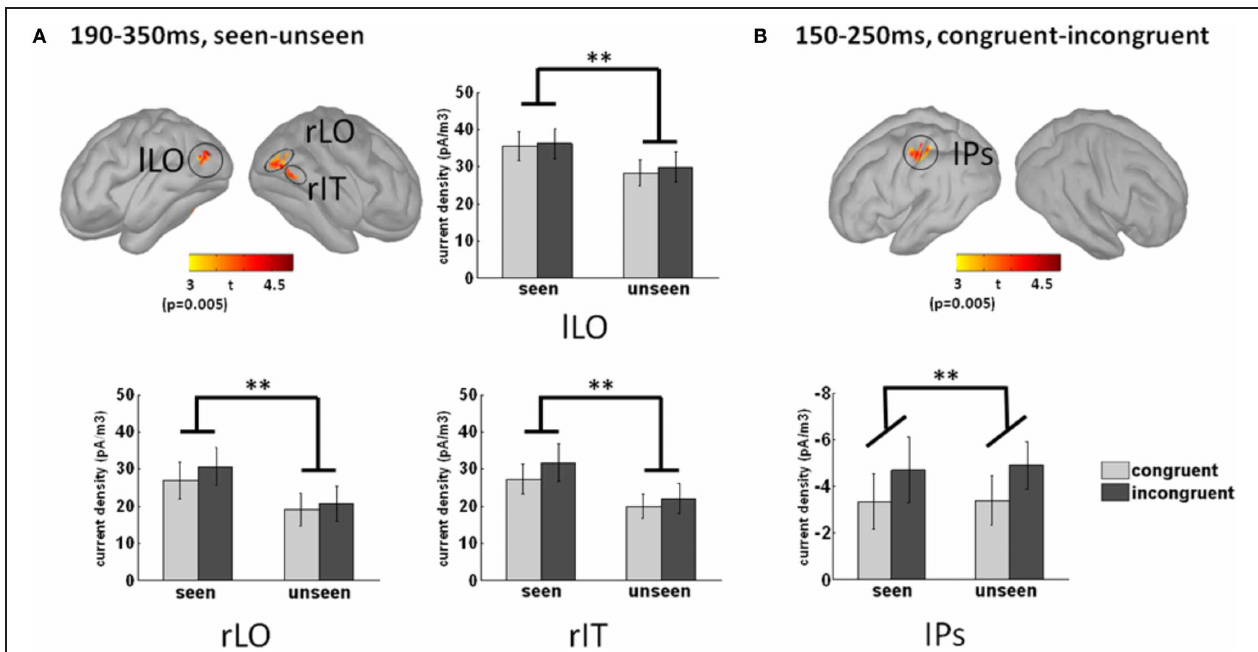
FIGURE 6 | Source localization of the main effects. (A) Awareness-related sources were obtained by contrasting seen and unseen trials in the 190–350 ms time-window. Three sources were observed, in the left and right lateral occipital cortices (lLO and rLO respectively), and in the right posterior infero-temporal cortex (rIT). The bar graphs depict activation strength in those three regions in each condition. Activation in those three regions was by definition significantly larger in seen trials than in unseen trials (main effect of awareness, p < 0 . 002). There was neither main effect of congruency ( p > 0 . 2) nor interaction ( p > 0 . 3) between congruency and